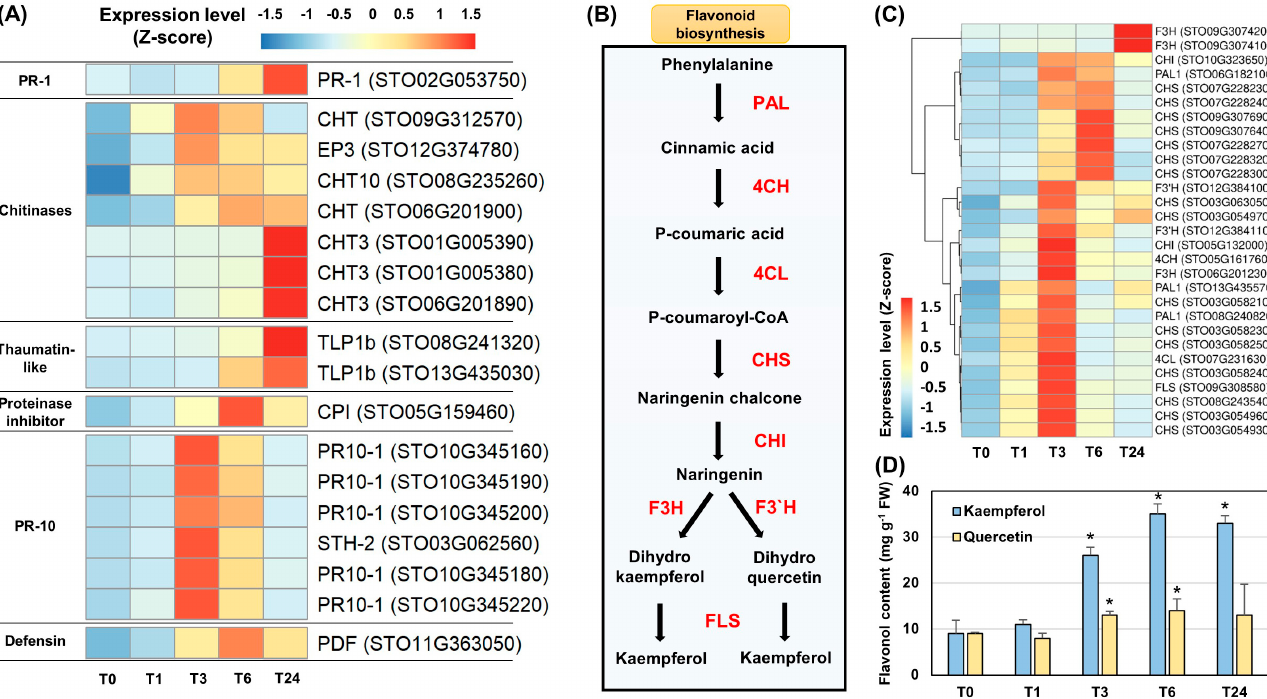
Figure 6. Expression analysis of genes encoding pathogenesis-related (PR) proteins and those involved in flavonoid biosynthesis induced following wounding in S . tora leaves. ( A ) Heatmap analysis of genes encoding PR proteins. ( B ) Flavonoid biosynthesis pathway in plants. PAL, phenylalanine ammonia-lyase; C4H, cinnamate 4-hydroxylase; 4CL, 4-couma-